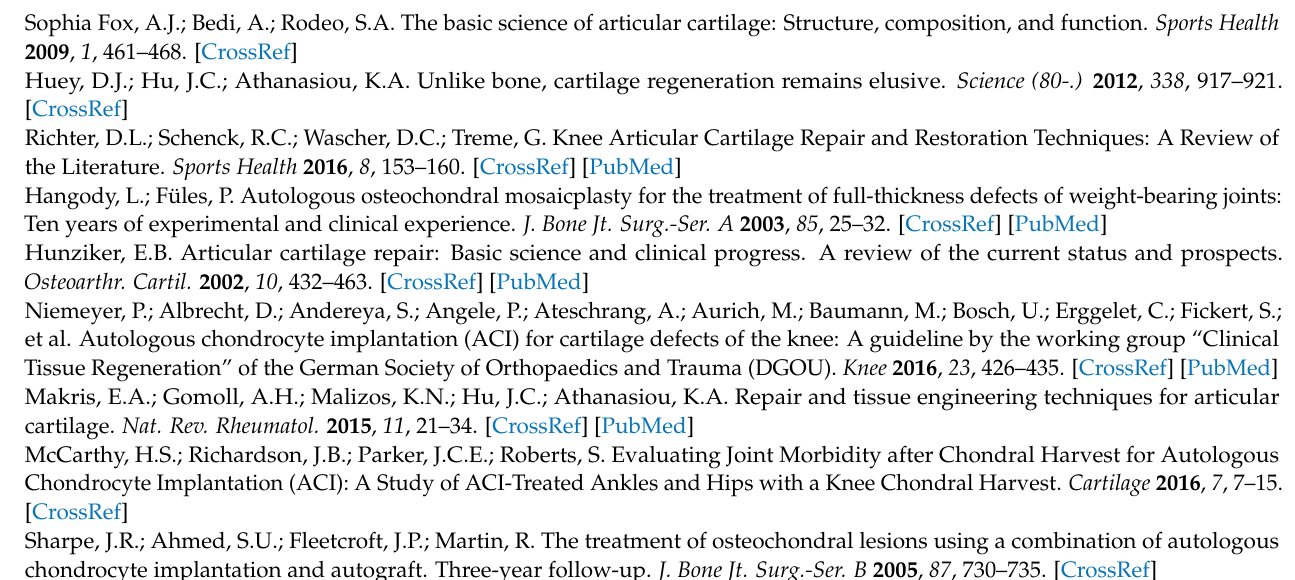
Figure S2: Gene expression characterization of human articular chondrocytes cultivated for 21 days in fibrin hydrogel in free swelling (static) or a direct perfusion bioreactor, Figure S3: Quantification of aggrecan core protein and type VI collagen immunofluorescence at the single-cell